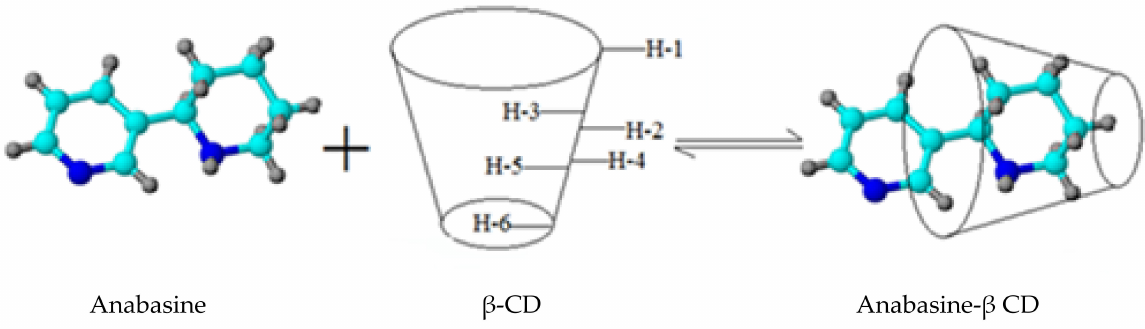
Figure 16. Diagram of the inclusion complex anabasine- β CD